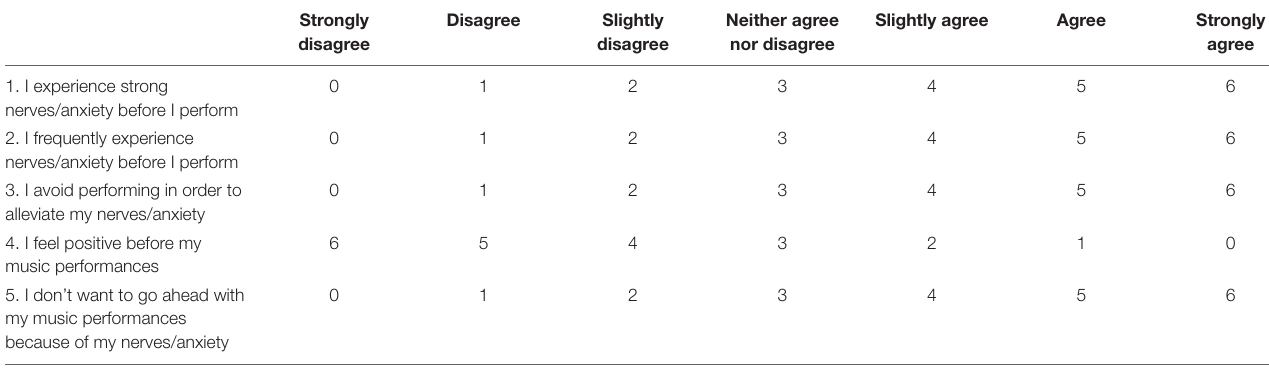
TABLE 2 | Mazzarolo Music Performance Anxiety Scale